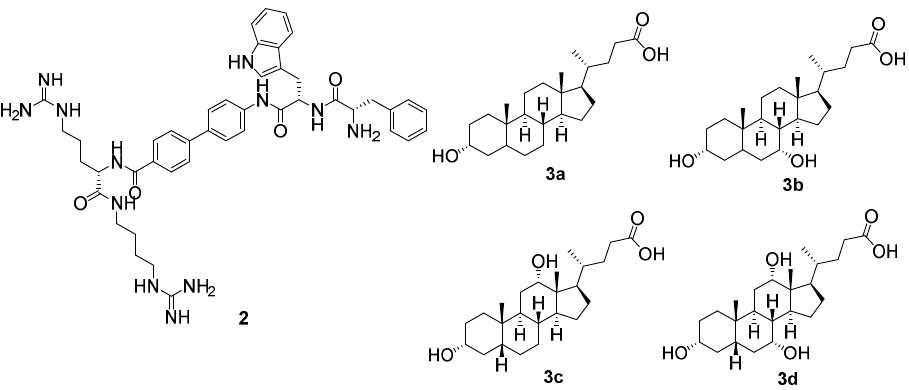
Figure 3. Structures of biphenyl-based peptidomimetic 2 and cholic acid scaffolds 3 .